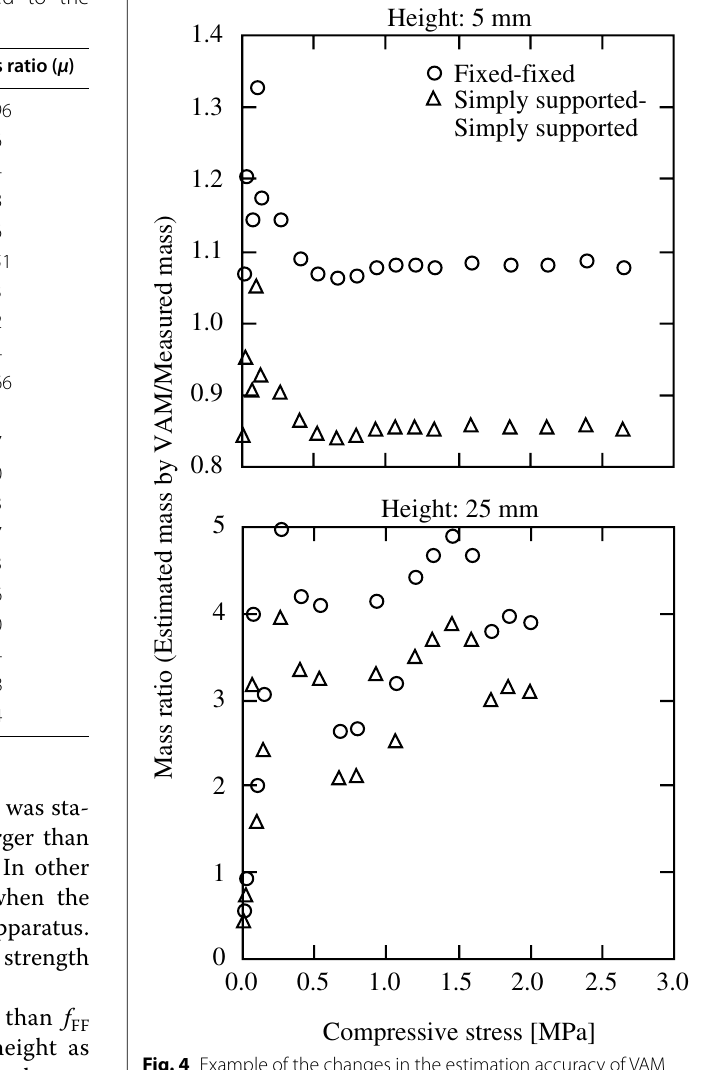
Table 1 Concentrated masses (steel plates) attached to the